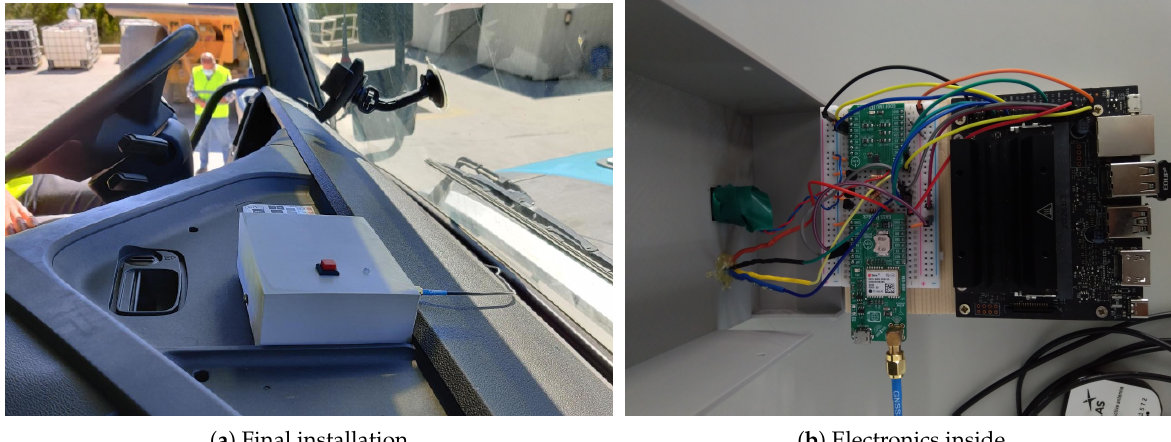
Figure 3. Sensor acquisition